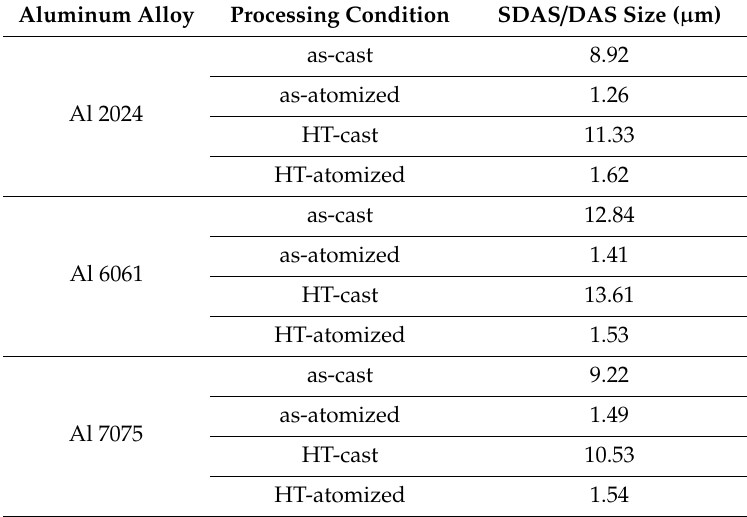
Table 5. The grain sizes for each of the conditions, which includes the as-cast, as-atomized, thermally treated casts, and thermally treated powders.